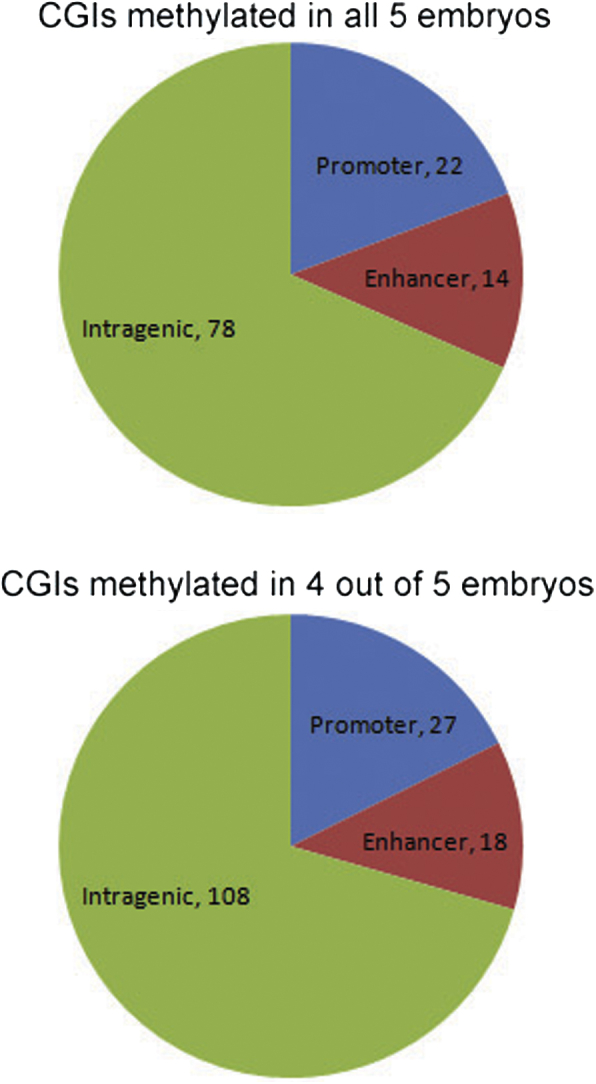
Analysis of the CGIs that were methylated in ≥4 embryos, to identify whether the methylated embryonic CGIs overlap with gene promoters, enhancers, or intragenic regions. The analysis of promoter, enhancer, and intragenic overlaps were performed independently; therefore, in some cases, the same CGI might overlap enhancer/promoter and intragenic regions, and therefore may have been counted more than once. CGI = CpG island.